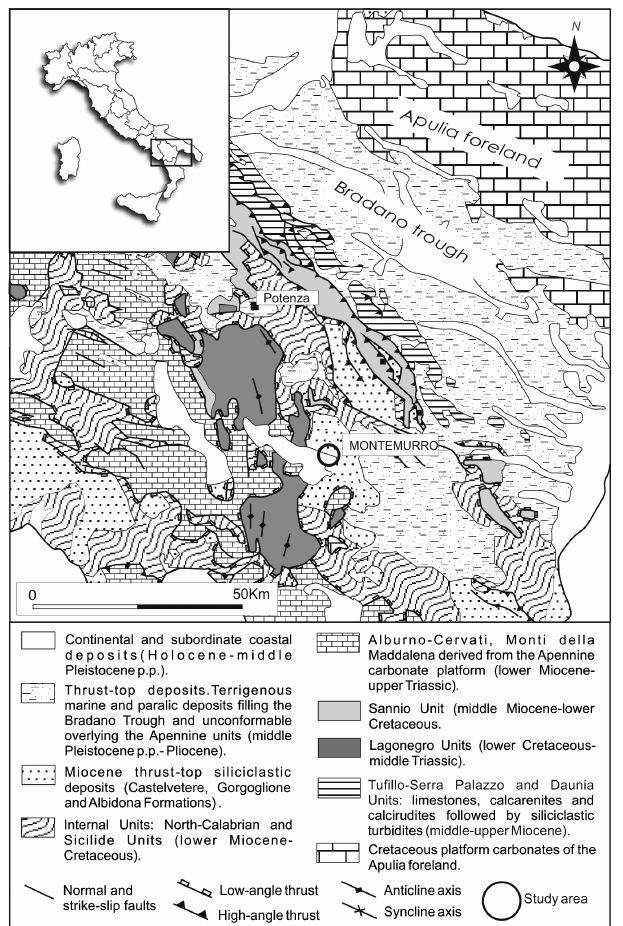
Figure 1. Geological sketch map of the Lucanian Apennines with the site of the study area (modified from Patacca and Scandone, 2007).